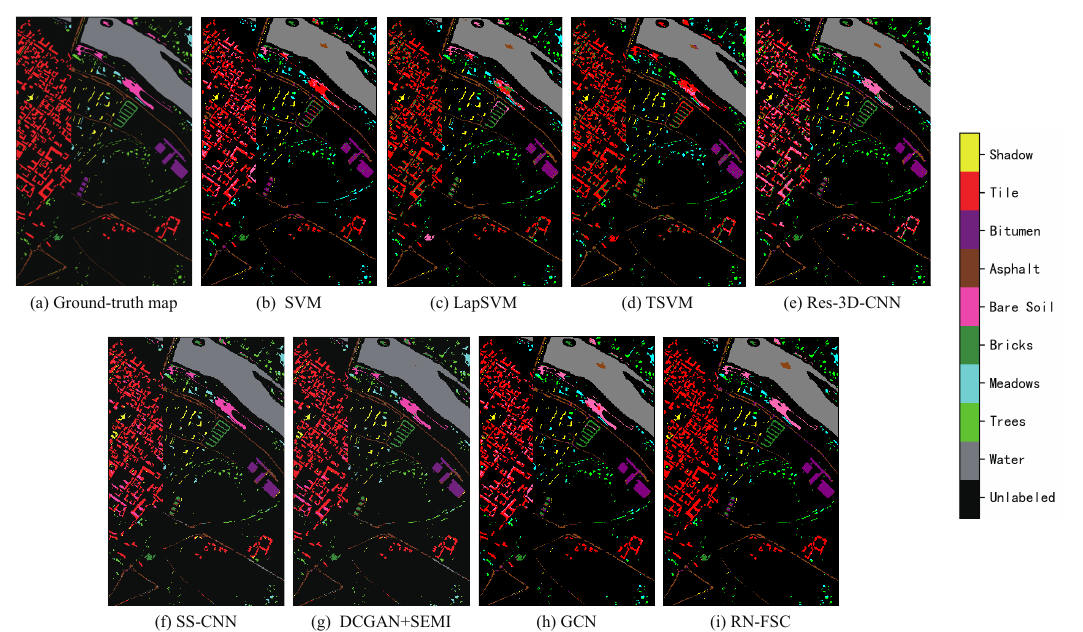
Figure 13. Classification maps resulting from different methods on the PC data set.